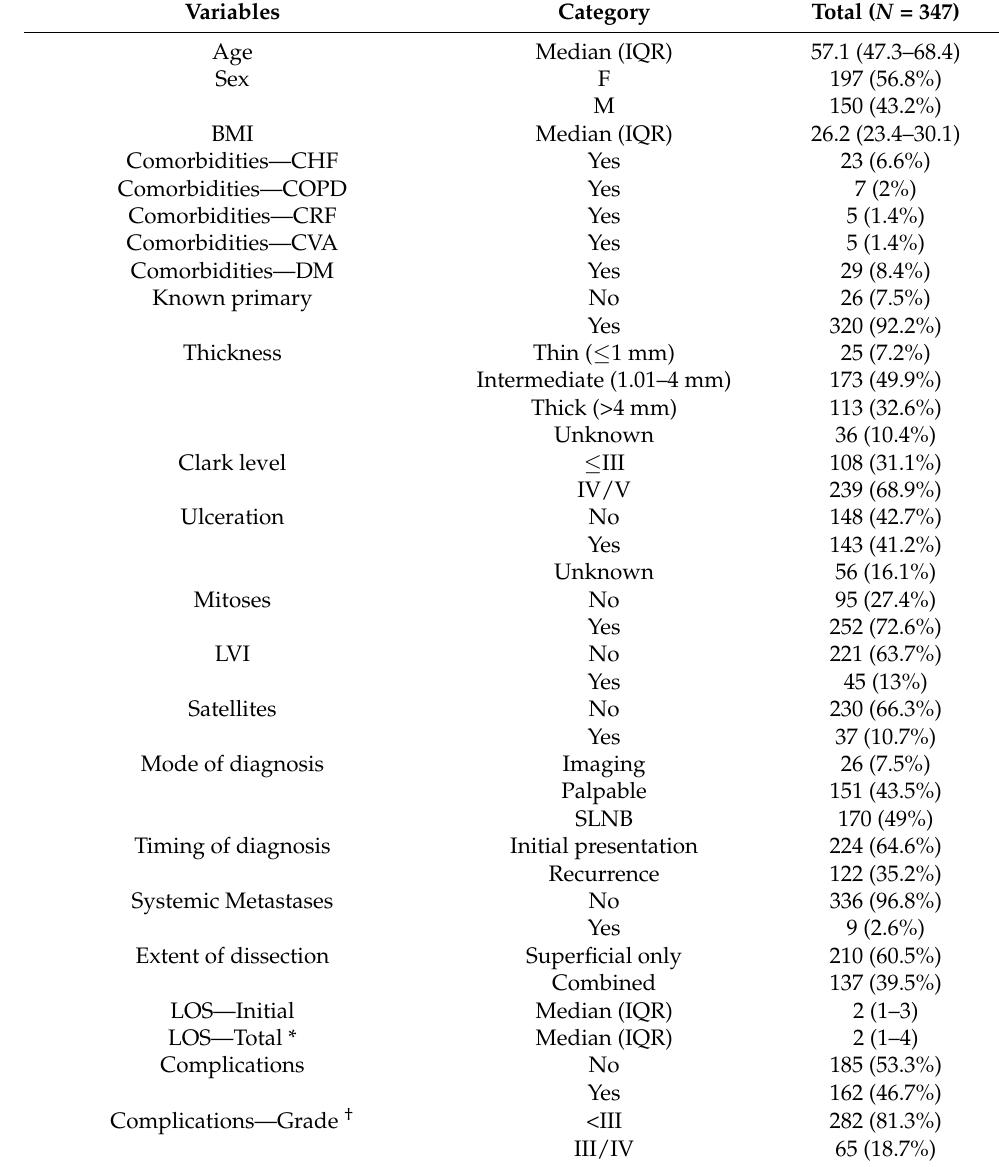
Table 1. Patient demographics and